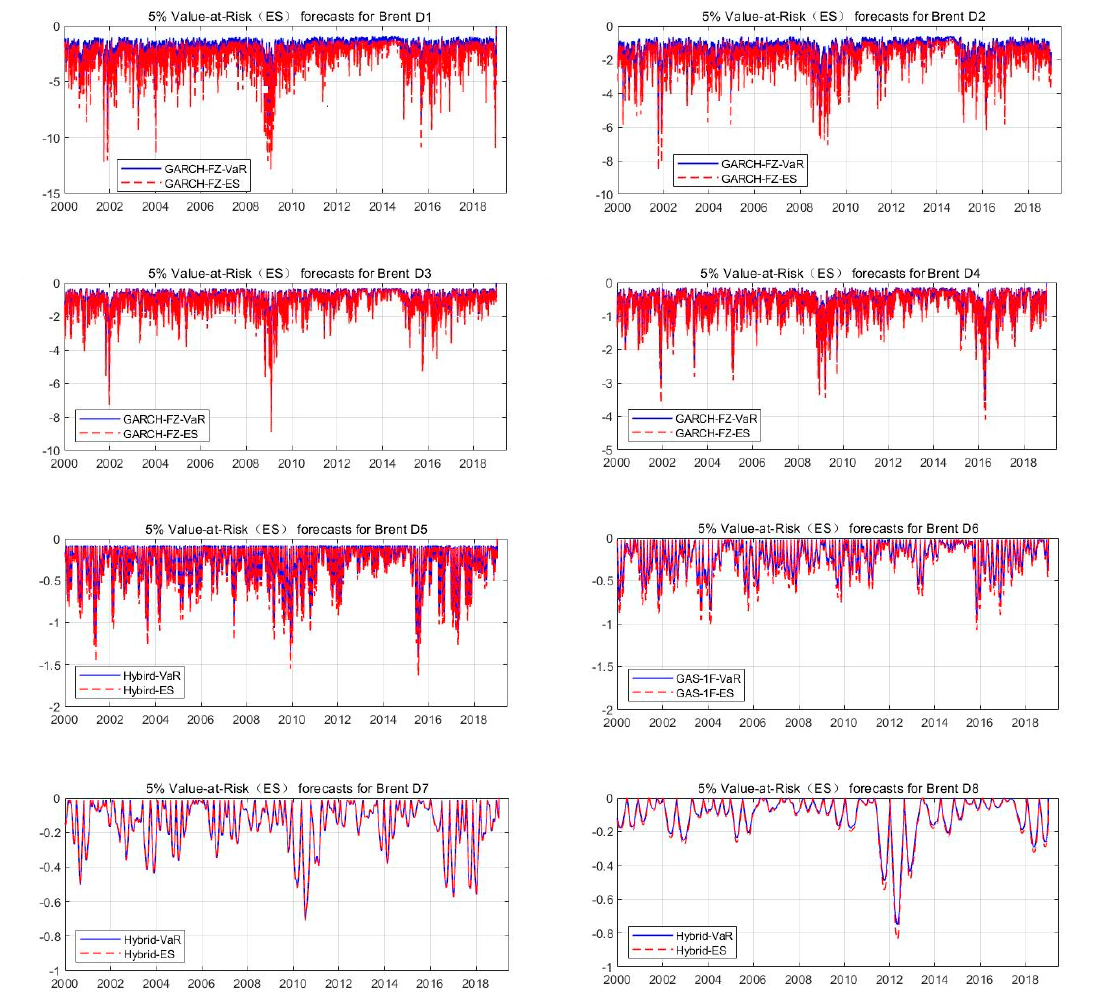
Figure 5. The forecasted 5% VaR and ES for the wavelet of the Brent crude oil price over the period of January 2000 to December 2018. The estimates are based on the model with the best fit from Table 6.